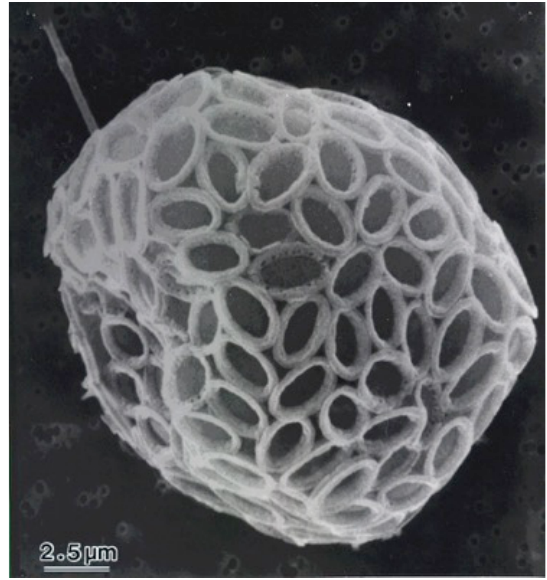
Figure 1. SEM image of Pleurochrysis carterae .